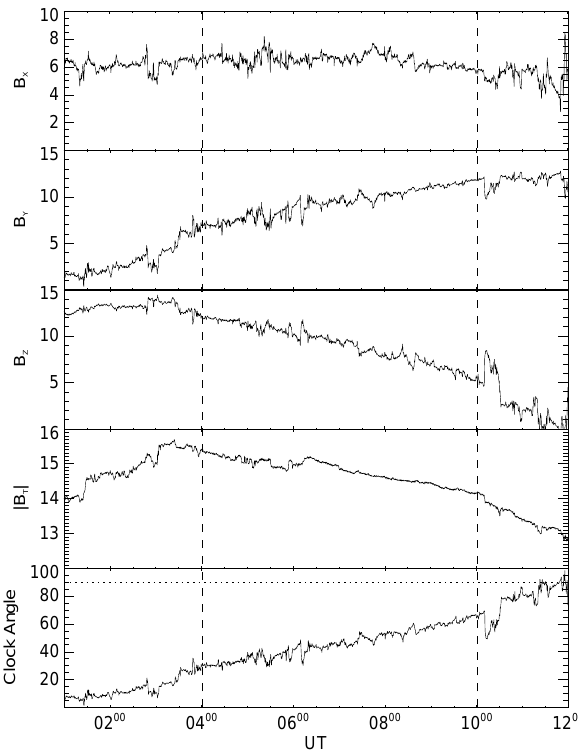
Fig. 3. Upstream interplanetary observations from the ACE space- craft for 01:00–12:00UT on 20 March 2002, lagged by 71min to account for the propagation delay to the ionosphere. The top three panels show IMF data in GSM co-ordinates, and the bottom two panels show the field magnitude and clock angle. The clock an- gle is defined with respect to north, such that 0 ◦ corresponds to a transverse field purely in the + z direction (northward), ± 90 ◦ to ± y (respectively) and ± 180 ◦ to − z